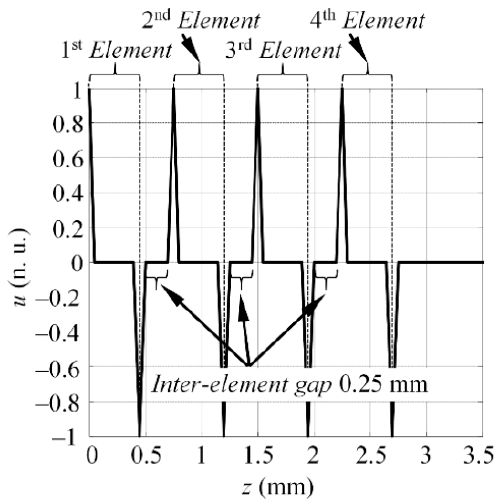
Figure 14. The particle velocity distribution which was required to excite the S 0 mode in case the four array elements were fired at the same time.